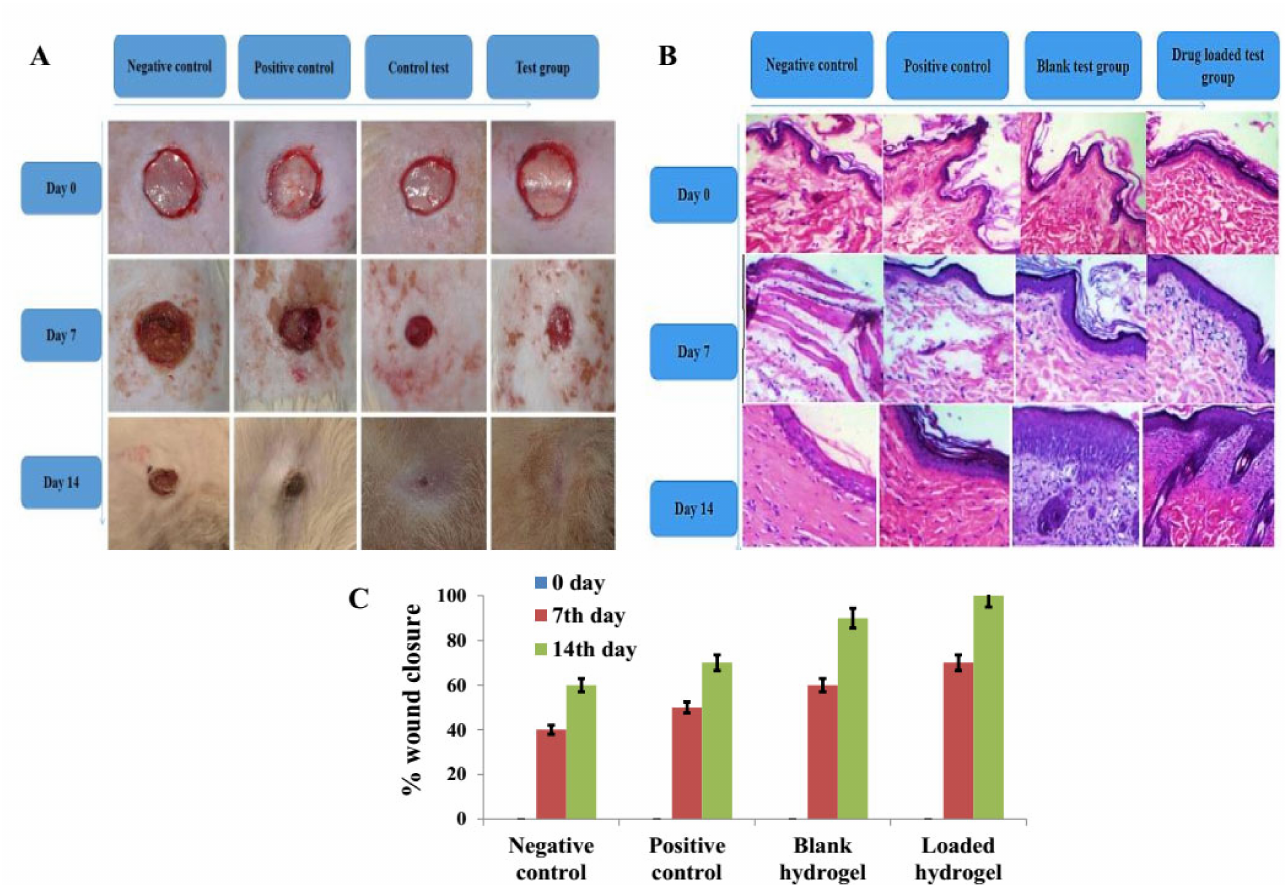
Figure 6. ( A ) % Wound closure of different groups on day 0, 7, and 14 of the incision; ( B ) wound section histology of different groups on day 0, 7, and 14, stained with hematoxylin and eosin stain; ( C ) macroscopic appearance of wounds postsurgery in four groups on day 0, 7, and 14 of the